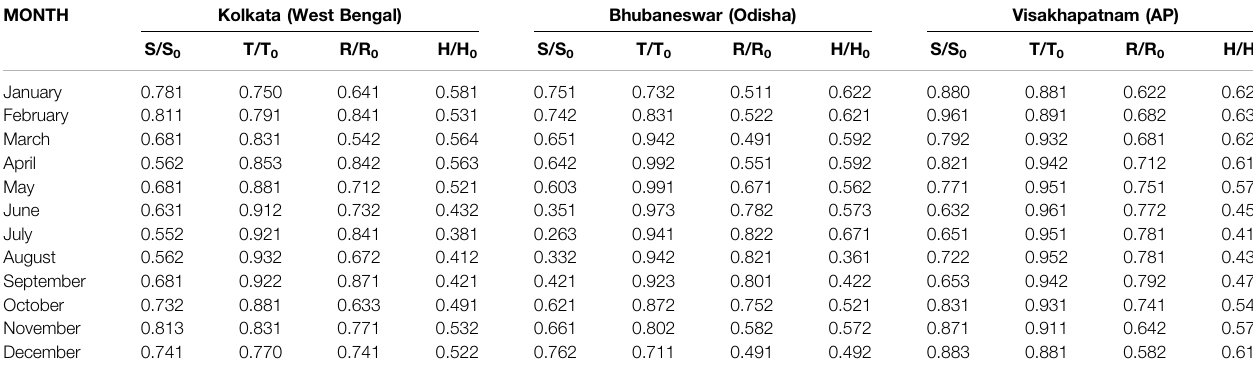
TABLE 8 | Monthly average solar radiation